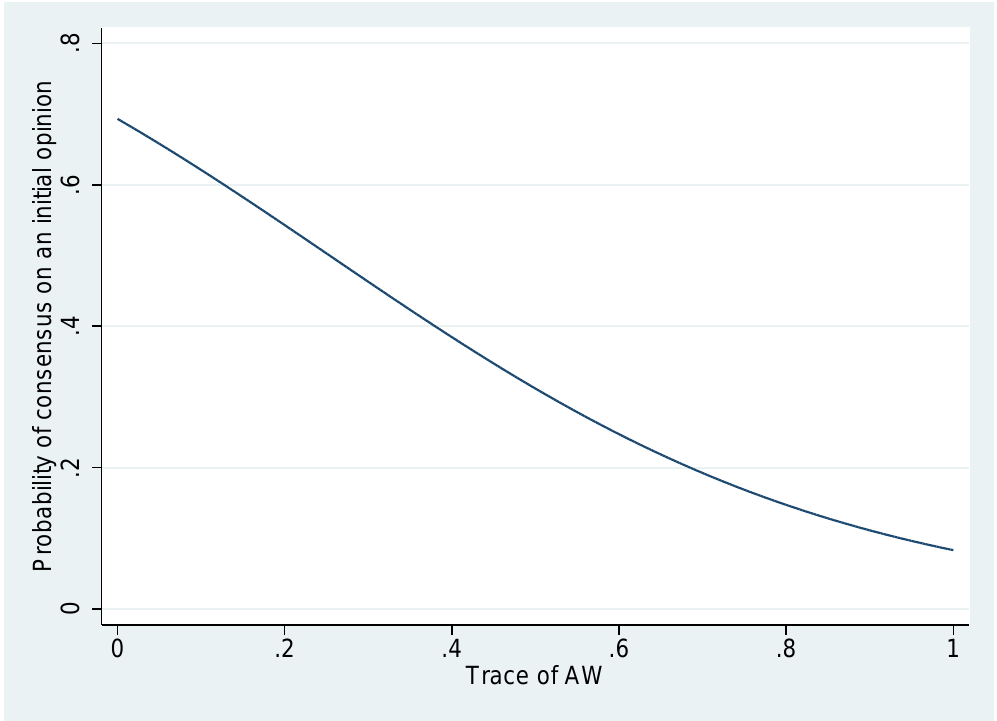
Figure 12: Estimated probability of group consensus on an initial opinion conditional on the trace of AW , a ii w ii . Balanced random-effects logistic regression longitudinal design; STATA 12 xtlogit trace ( AW ) = ∑ n i = 1 implementation; n = 450. Plot of estimated probabilities based on the odds ratio estimates β constant = 2.260 (s.e. = 0.899), p ≤ 0.05, β trace = 0.0421 (s.e. = 0.026), p ≤ 0.001, log likelihood −